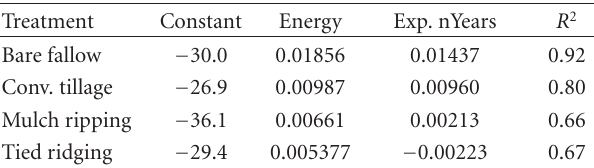
Table 1: The e ff ect of rainfall energy and number of years of cultivation on runo ff under di ff erent tillage systems at Makoholi Contill